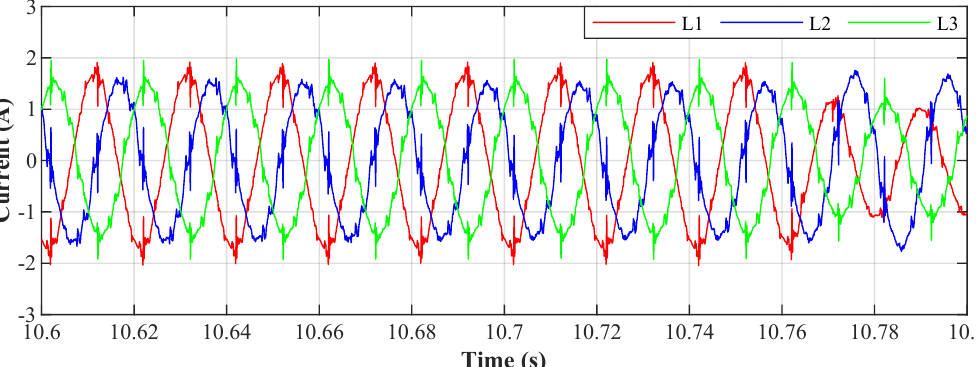
Figure 16. Switched on test polygon; current waveforms after applying the LMS algorithm.